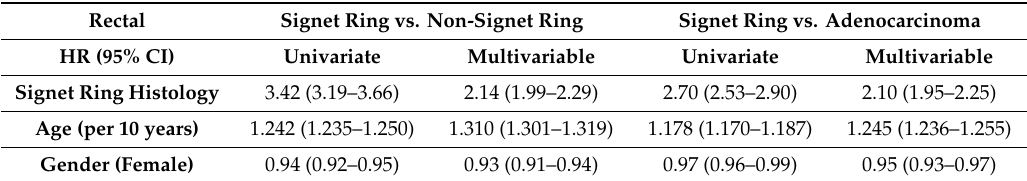
Table 8. Derived univariate and multivariable Cox-proportional hazard ratios (HR) of mortality for rectal